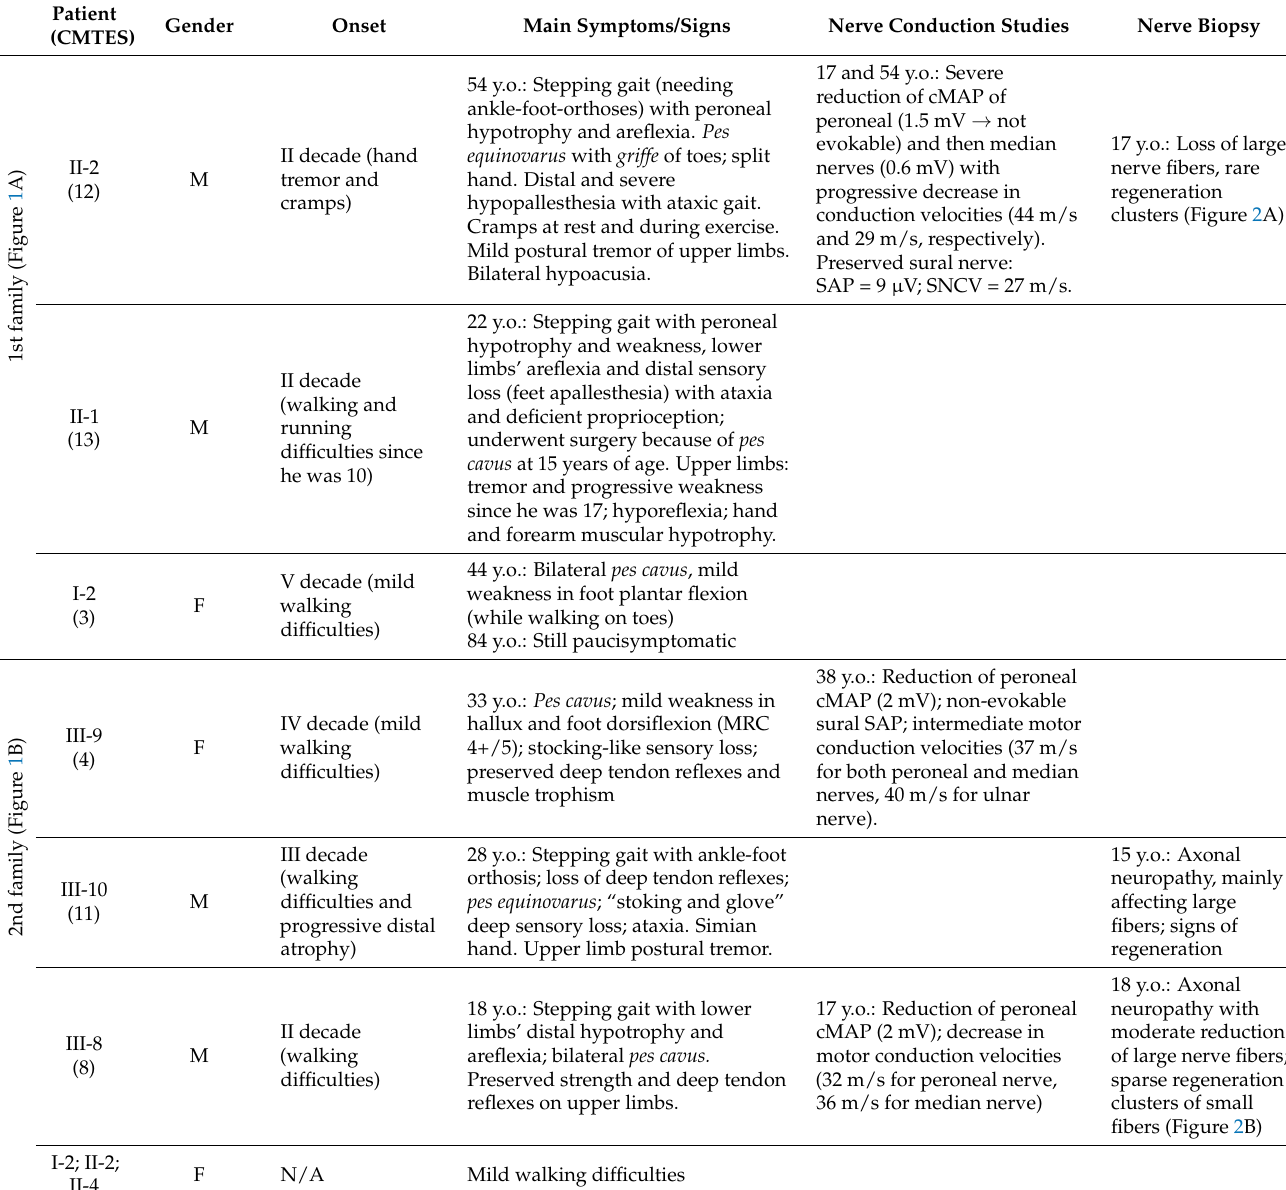
Table 1. Summary of the main clinical features of the patients. Abbreviation: CMTES = Charcot-Marie-Tooth Examination Score; M = male; F = female; y.o. = year old; MRC = Medical Research Council Scale for muscle strength; cMAP = compound motor action potential; MCV = motor conduction velocity; SAP = sensory action potential; SNCV = sensory nerve conduction